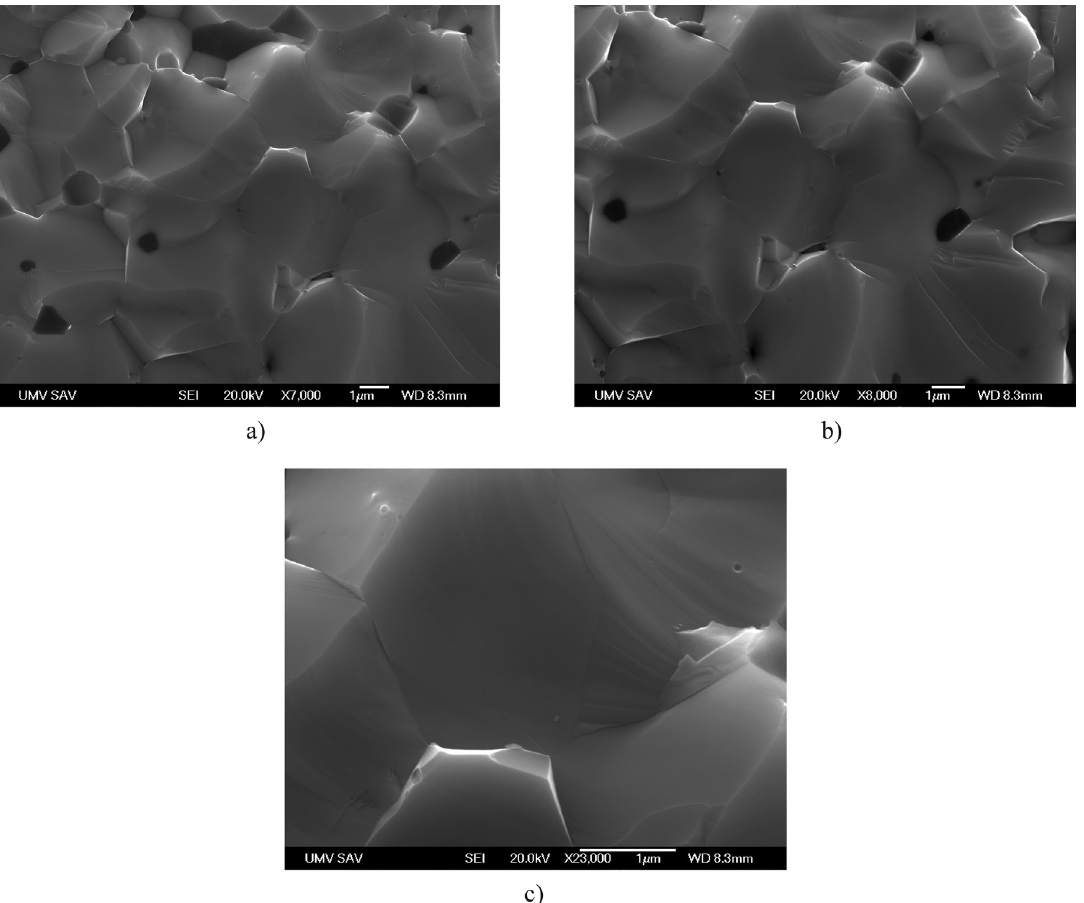
Fig. 5: Fracture of monolithic MoSi 2 broken at room temperature after finishing creep testing at 1473 K and 100 MPa: a) transcrystalline cleavage of coarse grains, b) fracture in detail and c) detail of fracture at high